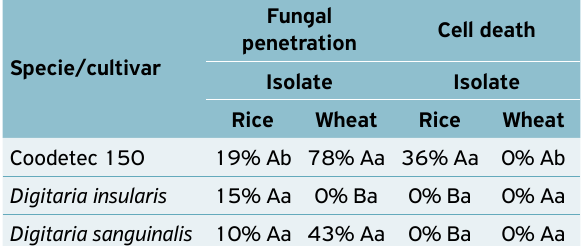
Table 3. Average values of fungal penetration and cell death (with papilla signal) in wheat and Digitaria plants 48 hours after inoculation with Magnaporthe oryzae isolates, 2015 (Aquidauana, Mato Grosso do Sul).